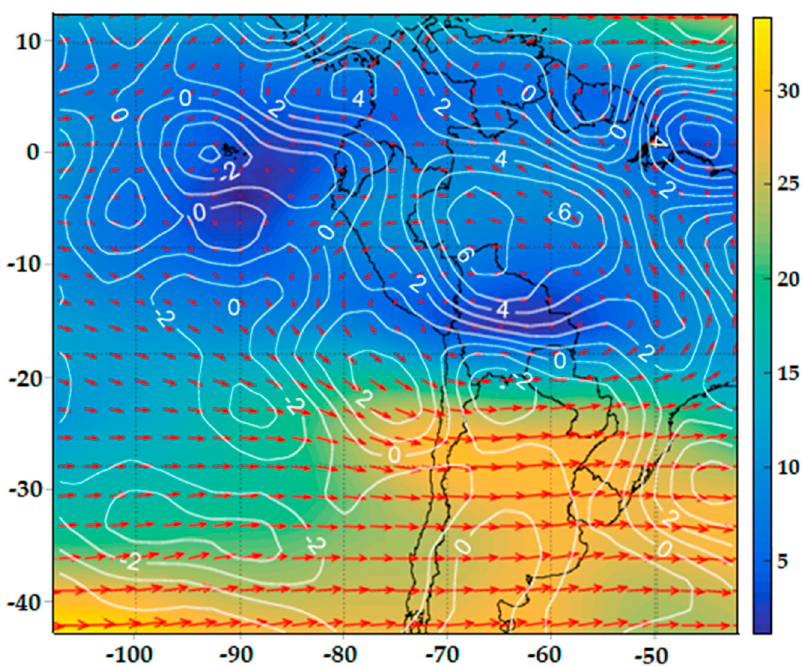
Figure 11. Average 200 hPa wind field (m s − 1 ) and divergence (s − 1 × 10 6 ) of the 40 cases.